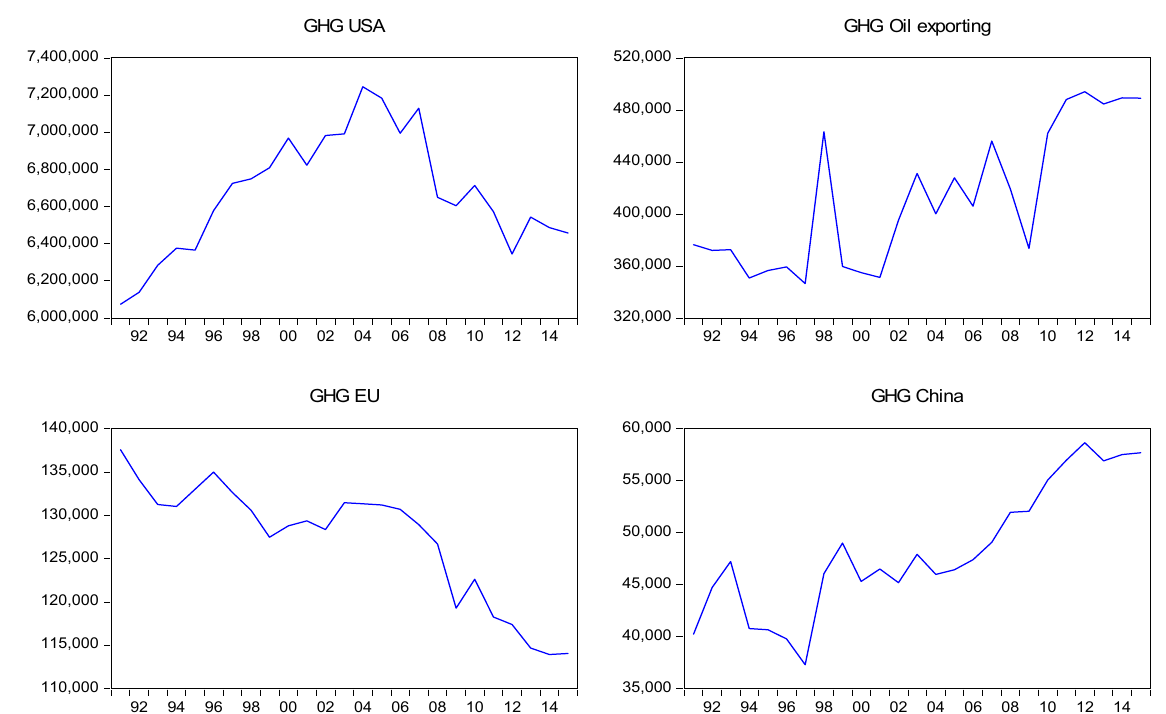
Figure 2. The trend of the total greenhouse gas (GHG) emissions in USA, Oil-exporting, EU, and China. Source: Authors’ calculation using annexed data sources.